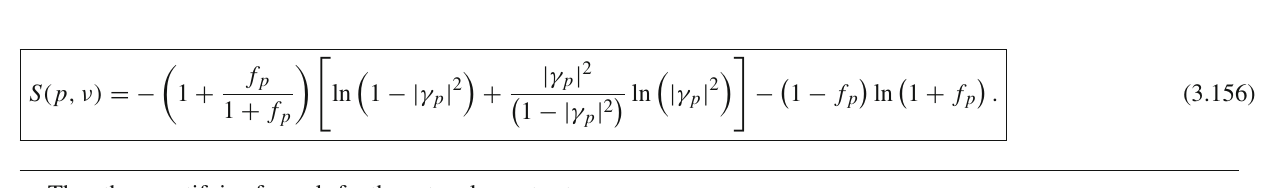
Fig. 6 Behaviour of energy spectrum for axion in de Sitter space for ‘ + ’ branch of solution of | γ p | and | (cid:17) p , n